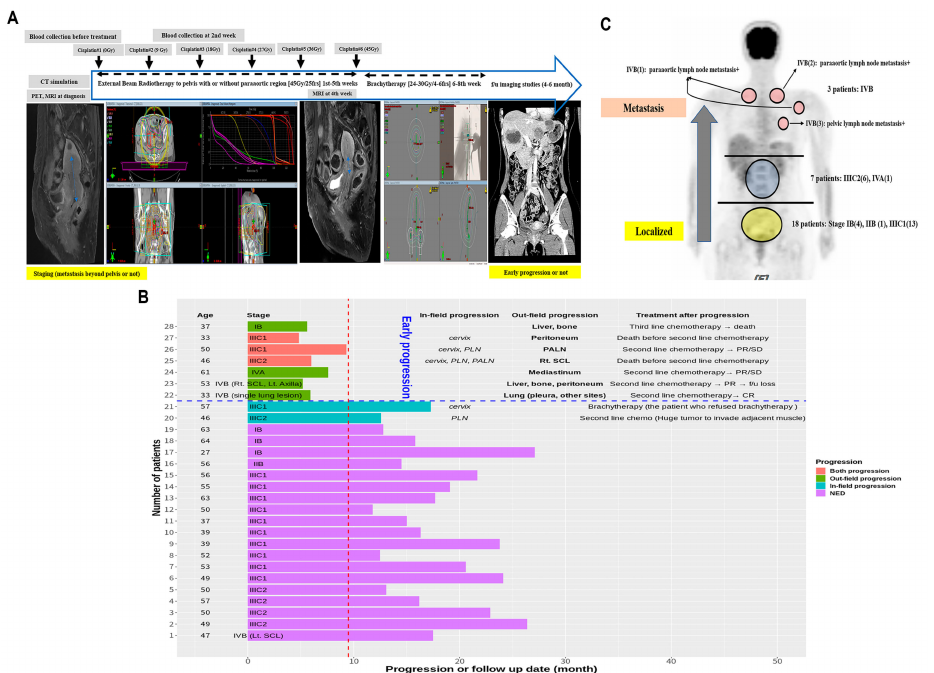
Figure 1. Transcriptomic analysis of miRNAs within exosomes isolated from the plasma of 28 patients with cervical cancer. ( A ) Clinical endpoints and blood sampling timeline. ( B ) Bar graph of follow-up duration and description of early progression and second-line treatment. ( C ) Metastatic sites according to the 2018 International Federation of Gynecology and Obstetrics (FIGO) staging. One patient with bladder invasion (stage IVA) also showed para-aortic lymph node